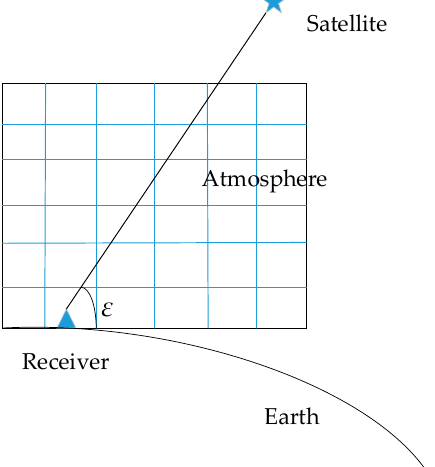
Figure 2. Schematic diagram of slant tropospheric delay (STD) and slant wet delay (SWD) Figure. 2 Schematic diagram of slant tropospheric delay (STD) and slant wet delay (SWD) simulation.